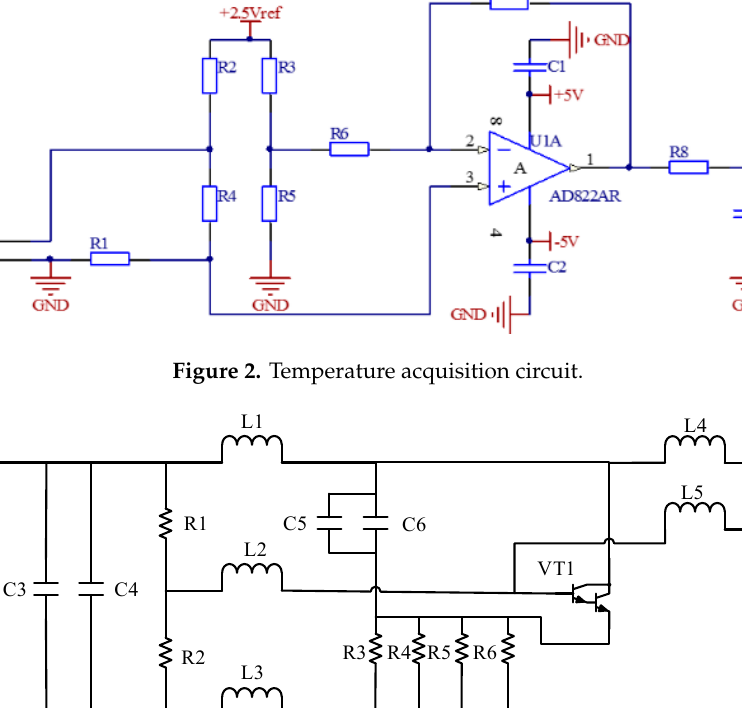
Figure 3. High frequency oscillator circuit.